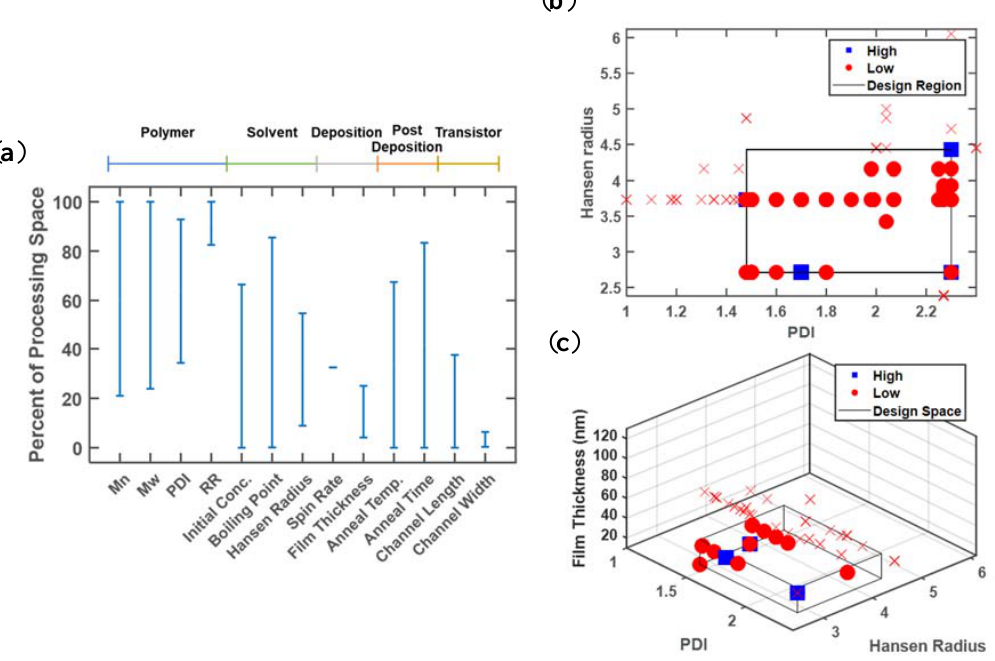
Figure 4. Representative analysis plots of ( a ) one ‐ , ( b ) two ‐ , and ( c ) three ‐ dimensional classifying design variables, resulting in charge mobility values exceeding 0.1 cm 2 /V ‐ s. Blue squares are data points above the cutoff, red dots represent points below the cutoff but within the target design region, and red x markers indicate all other data points below the cutoff but not within the target region. All axis ranges denote the full range of values present in the database.